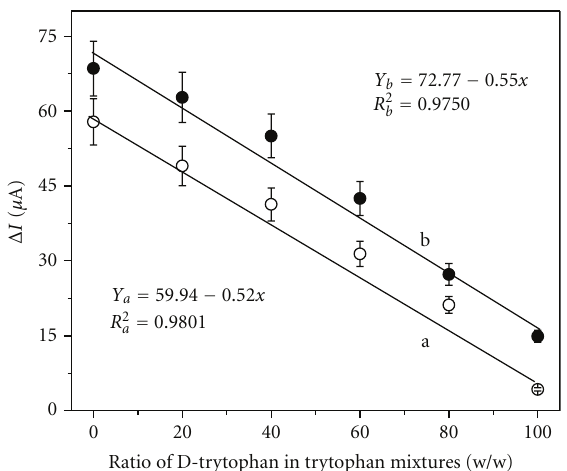
Figure 6: The relative change of the modified electrode oxidation current peak with enantiomeric composition of L- and D-Trp at di ff erent concentrations: (a) 2mM and (b)